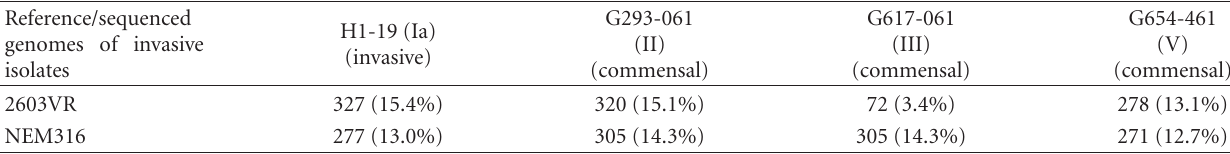
Table 2: Number (percentage) of variable probe sequences among four tester group B Streptococcus genomes using sequenced strains as a reference revealed by comparative genomic hybridization